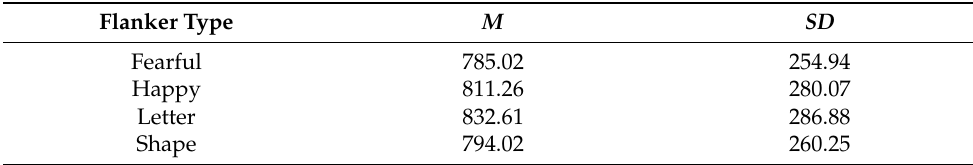
Table 5. Estimates of hit reaction times (before log-transformed) for each flanker type.